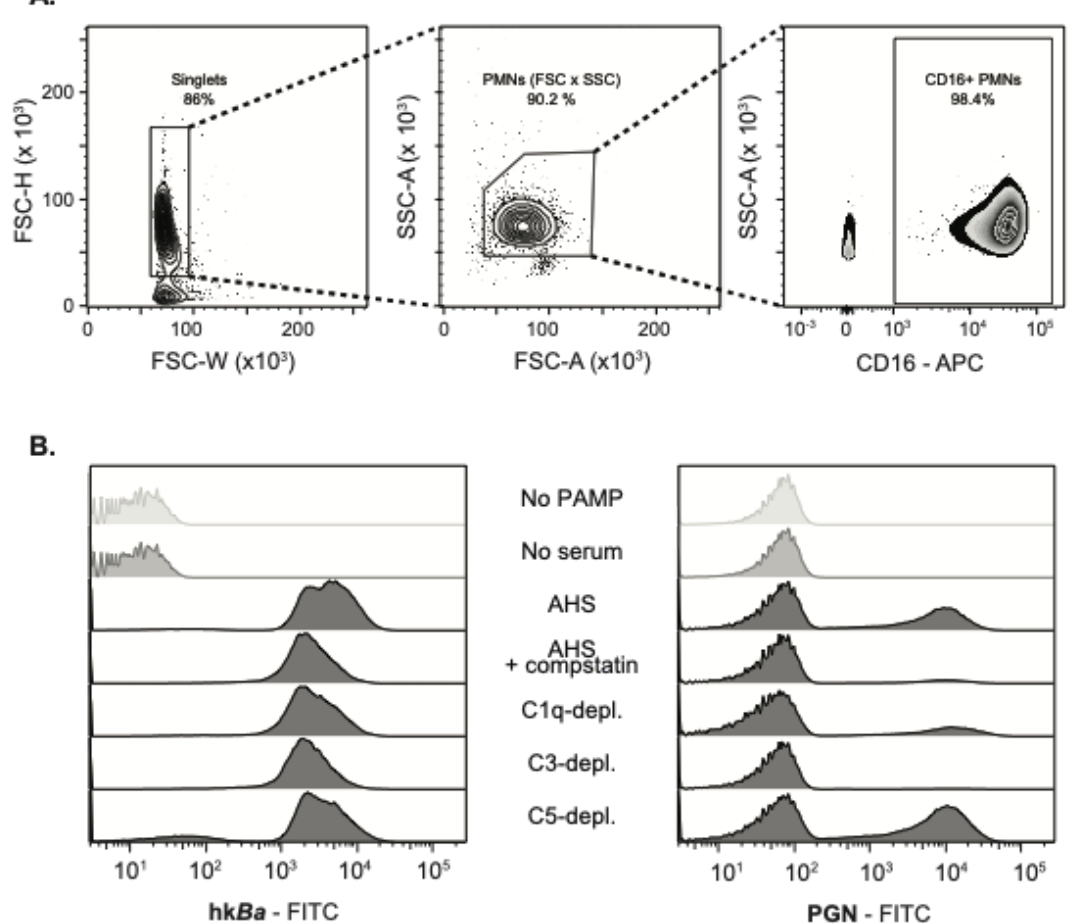
Figure 1. The interaction between polymorphonuclear neutrophils (PMNs) and Bacillus anthracis (hk Ba ) or anthrax peptidoglycan (PGN) is dependent on the complement opsonization of pathogen particles. ( A ) Flow cytometry gating strategy and exemplification of neutrophil purification (CD16 high leukocytes). ( B ) Histogram overlay of FITC-labelled hk Ba (left) and / or PGN (right) interaction with CD16 high PMNs isolated from a median responsive individual, in the presence of compstatin, a C3 convertase inhibitor, or the immunodepletion of complement factors.